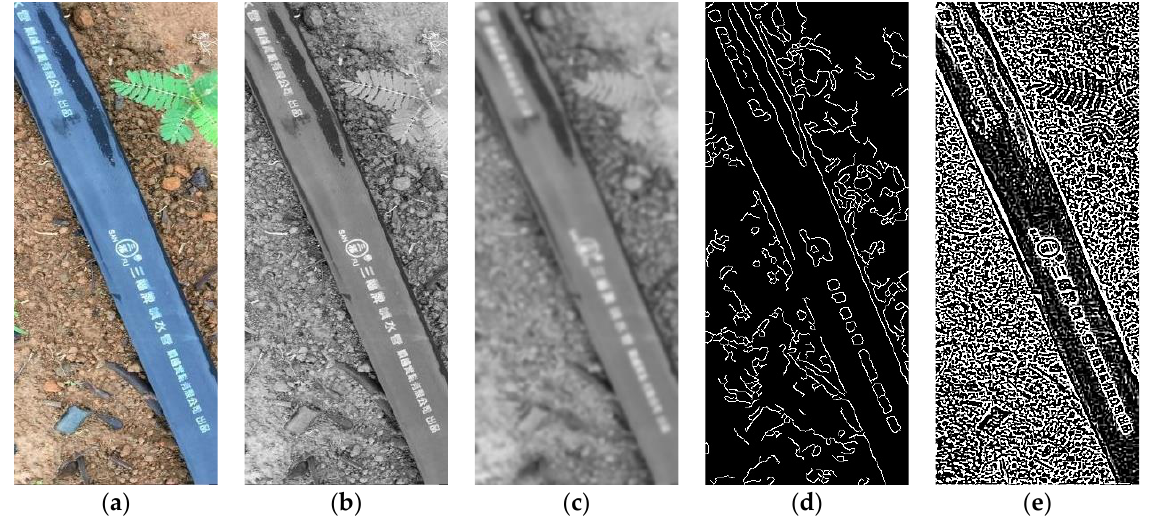
Figure 4. Process flow of edge detection: ( a ) original image; ( b ) grayscale; ( c ) Gaussian blur; ( d ) Canny edge detection; ( e ) Laplacian edge detection.